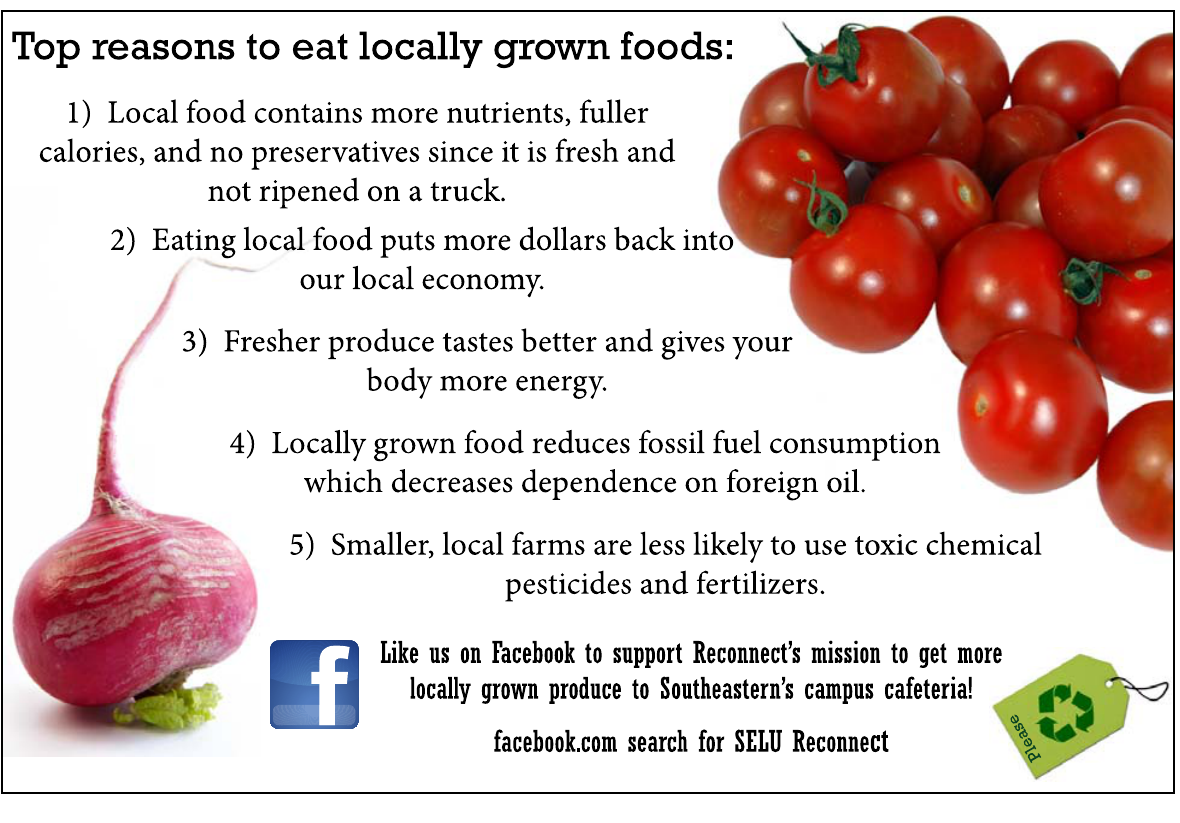
Figure 1. Back of the Information